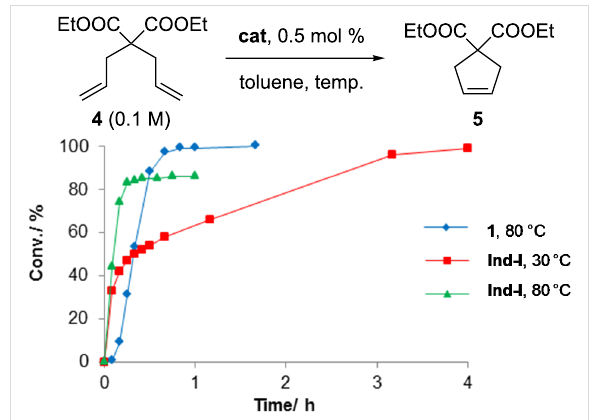
Figure 4: Reaction profiles of mixed phosphine/phosphite 1 and phos- phine-based Ind-I in the RCM of 4 (lines are visual aids and not curve